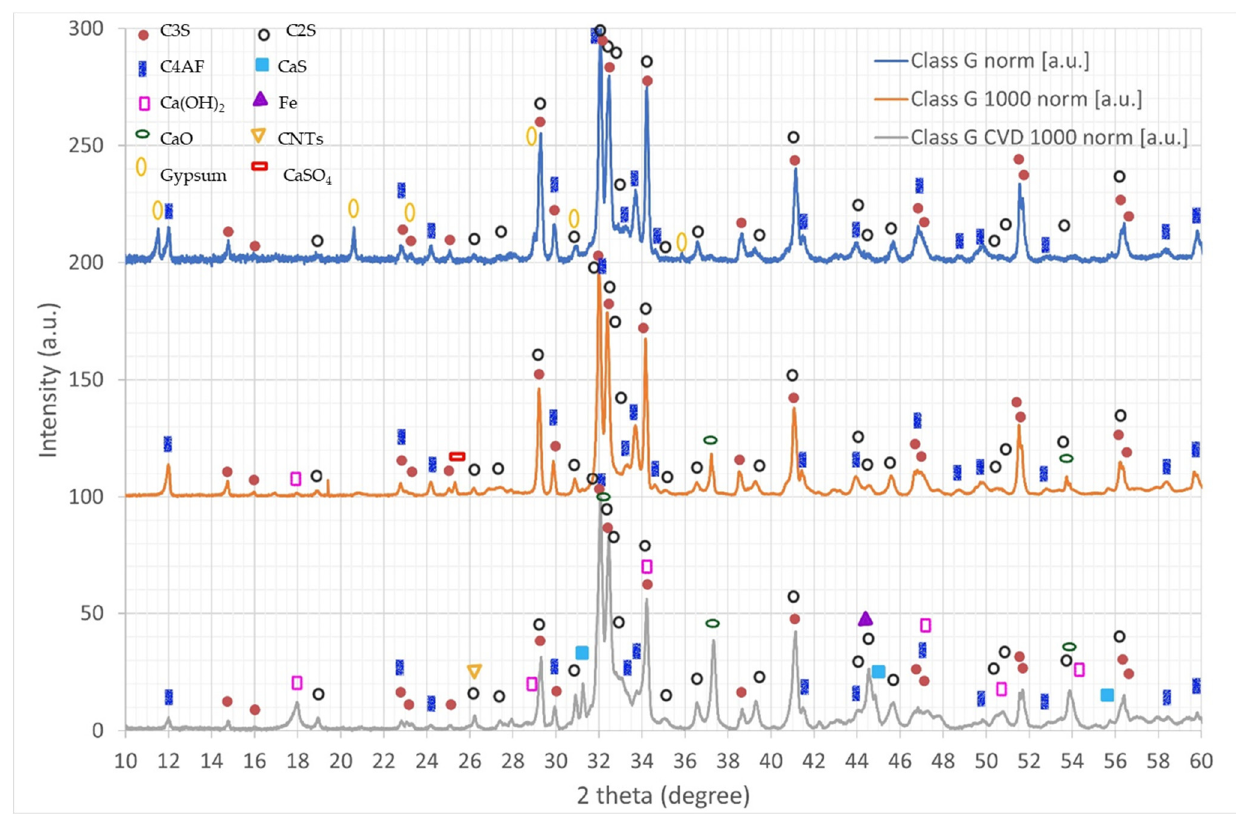
Figure 4. X-ray diffraction spectra of pristine clinker ( top ), clinker annealed at 1000 °C ( middle ), and clinker CVD-treated for grown CNTs ( bottom ).